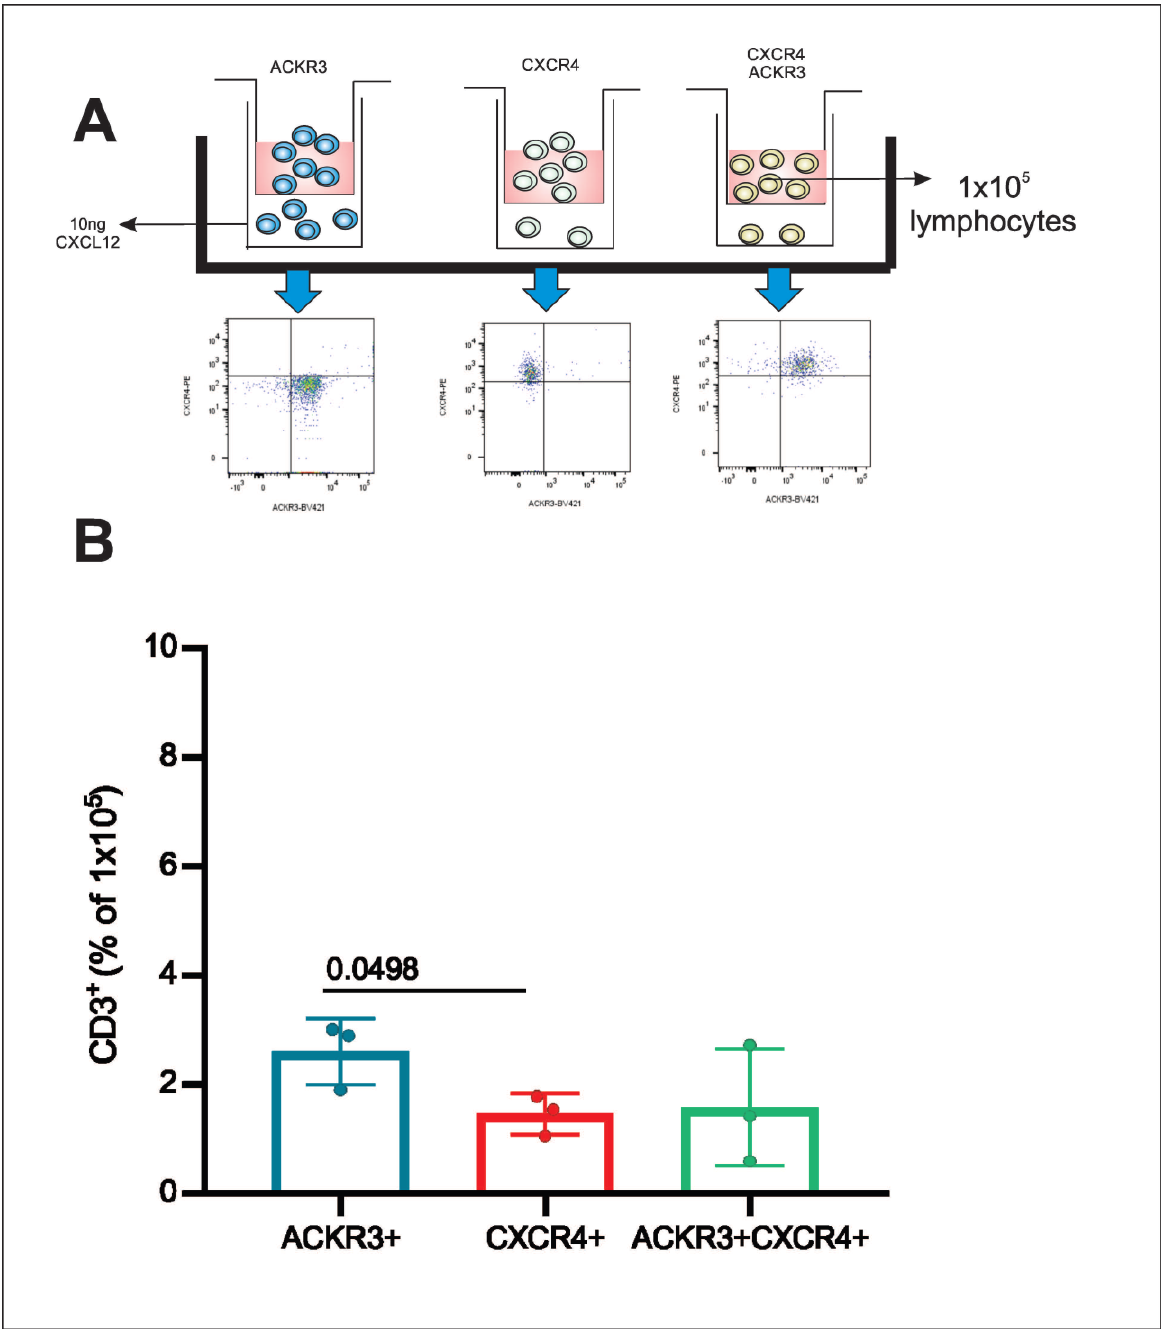
Figure 6. Migration of CD3 T lymphocytes after 24 h stimulation with CXCL12. ( A ) CD3 T lymphocytes from peripheral blood from healthy donors (n = 3) were isolated by flow cytometer cell sorting according to the surface expression of ACKR3, CXCR4 or ACKR3+CXCR4, and cultured in the presence of CXCL12 (under chamber) for 24 h in a transwell culture plate. ( B ) Afterwards, the cells that migrated were collected and the absolute number obtained by flow cytometry was also analyzed for the expression of ACKR3 (blue), CXCR4 (red) or ACKR3+CXCR4 (green). The percentage of CD3 T lymphocytes expressing ACKR3 or CXCR4 or ACKR3+CXCR4 that migrated via transwell towards the CXCL12 ligand was calculated in relation to the initial number of lymphocytes (1 × 10 5 ) placed on top of the insert (n =